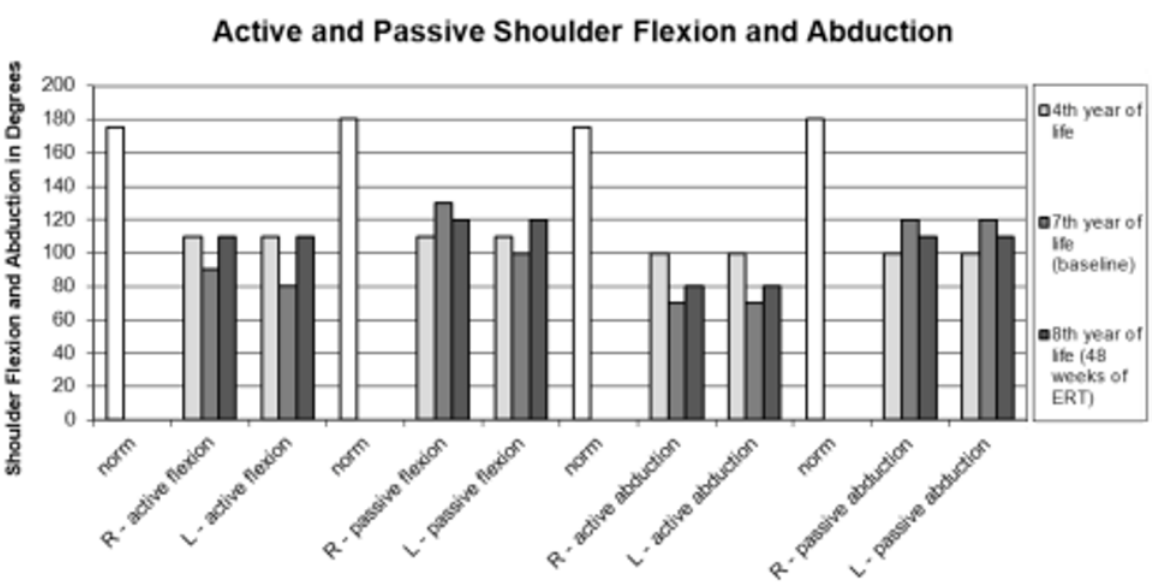
Figure 5. Active/passive shoulder flexion and abduction (in degrees) in MPS VI patient. R: right arm; L: left